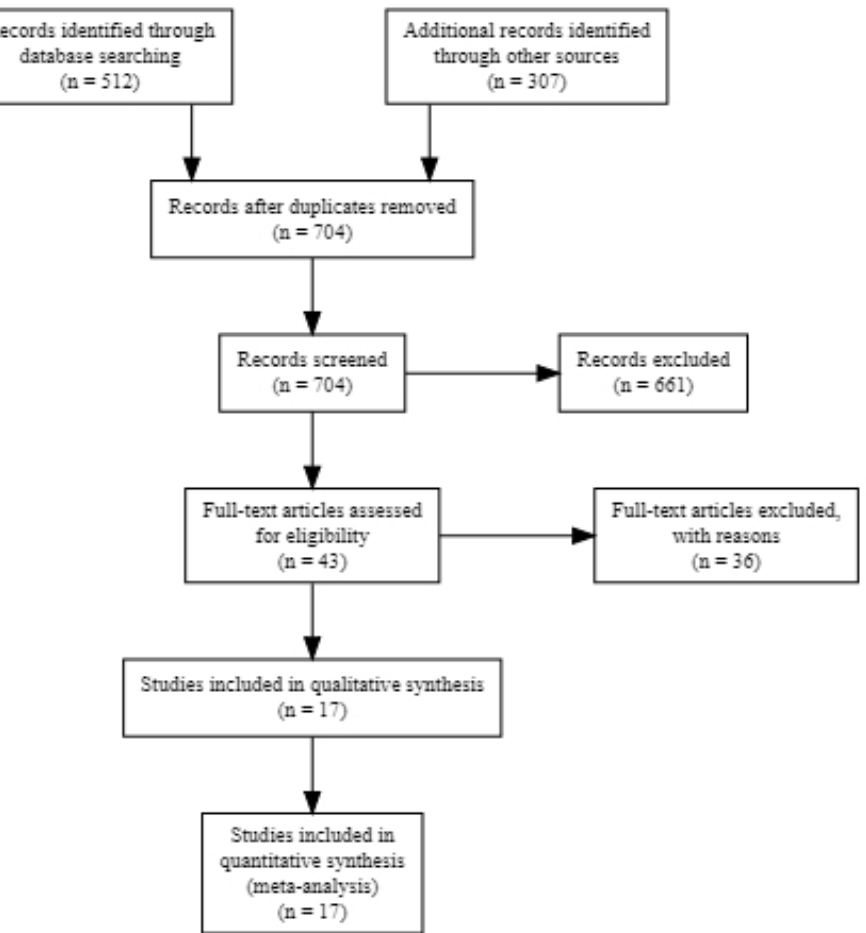
Figure 1. Study selection procedure (PRISMA flow Chart).